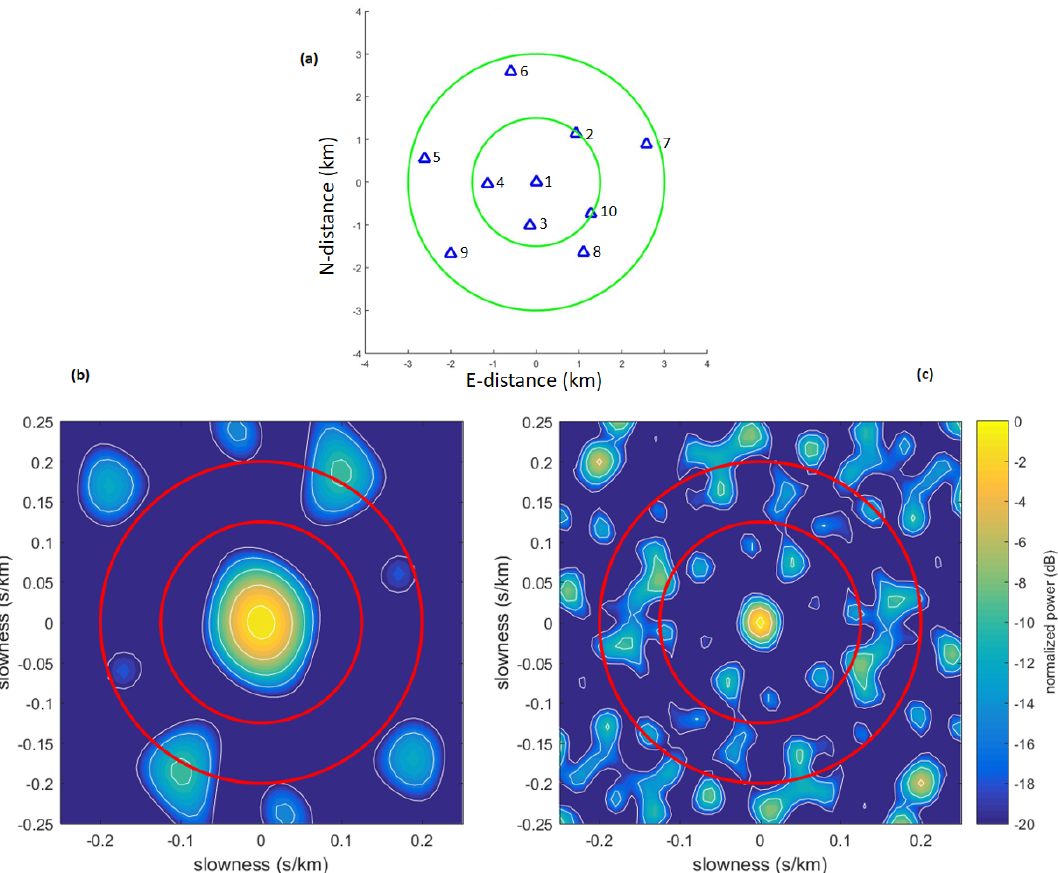
Figure 3. Configuration of the seismic array deployed on Rodrigues Island (a) . Station locations are indicated by blue triangles. The green circles represent inner and outer rings of the array with a radius of ∼ 1 . 5 and ∼ 2 . 5km, respectively, from the central (reference) station. The array transfer function of the Rodrigues array is shown at 2Hz (b) and 5Hz (c) . The inner and the outer red rings correspond to an apparent velocity of 8 and 5kms − 1 , respectively. In the real-data analysis, the apparent velocity at which the maximum occurs is used as a first indication to discriminate between crustal and upper-mantle ray